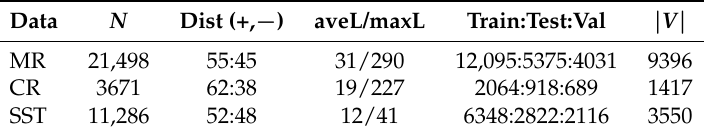
Table 1. Detailed statistics of the